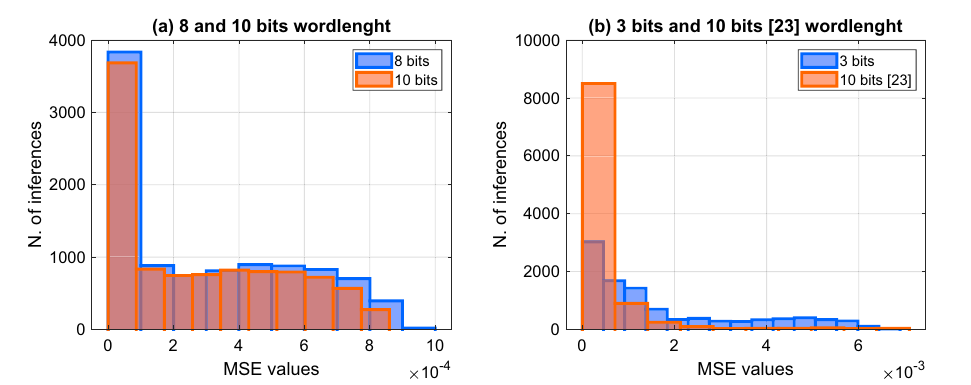
Figure 6. ( a ) ResNet-50, ( b ) VGG-16, ( c ) VGG-19, ( d ) InceptionV3, ( e ) MobileNetV2 classification results.